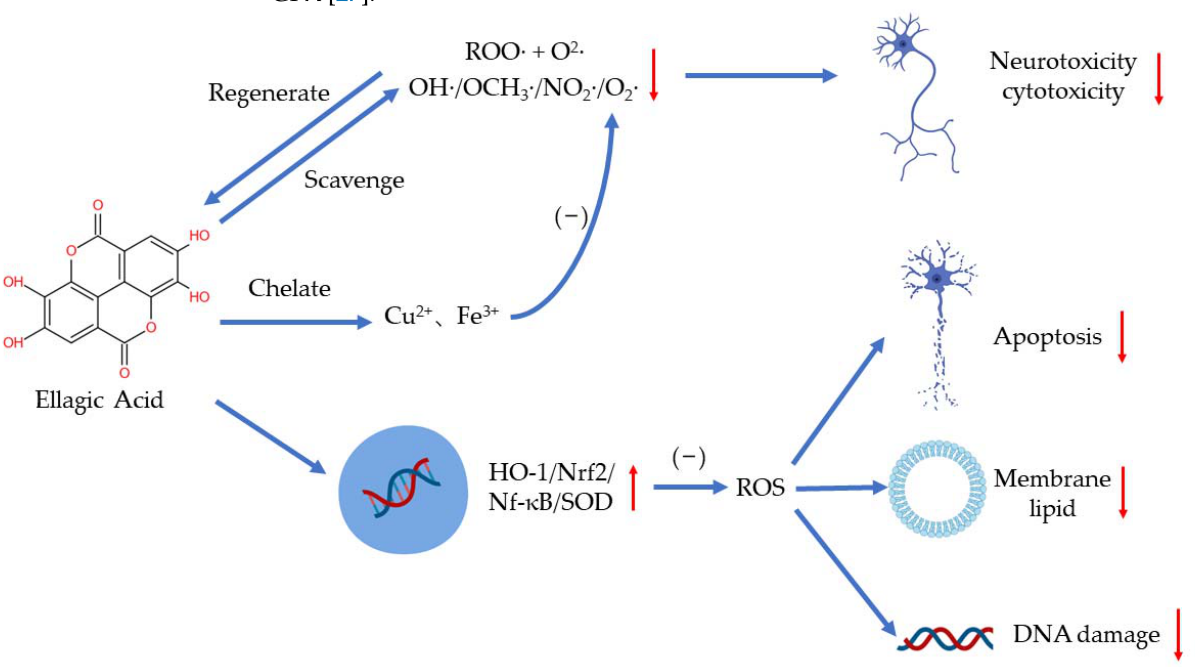
Figure 2. The antioxidant effects of